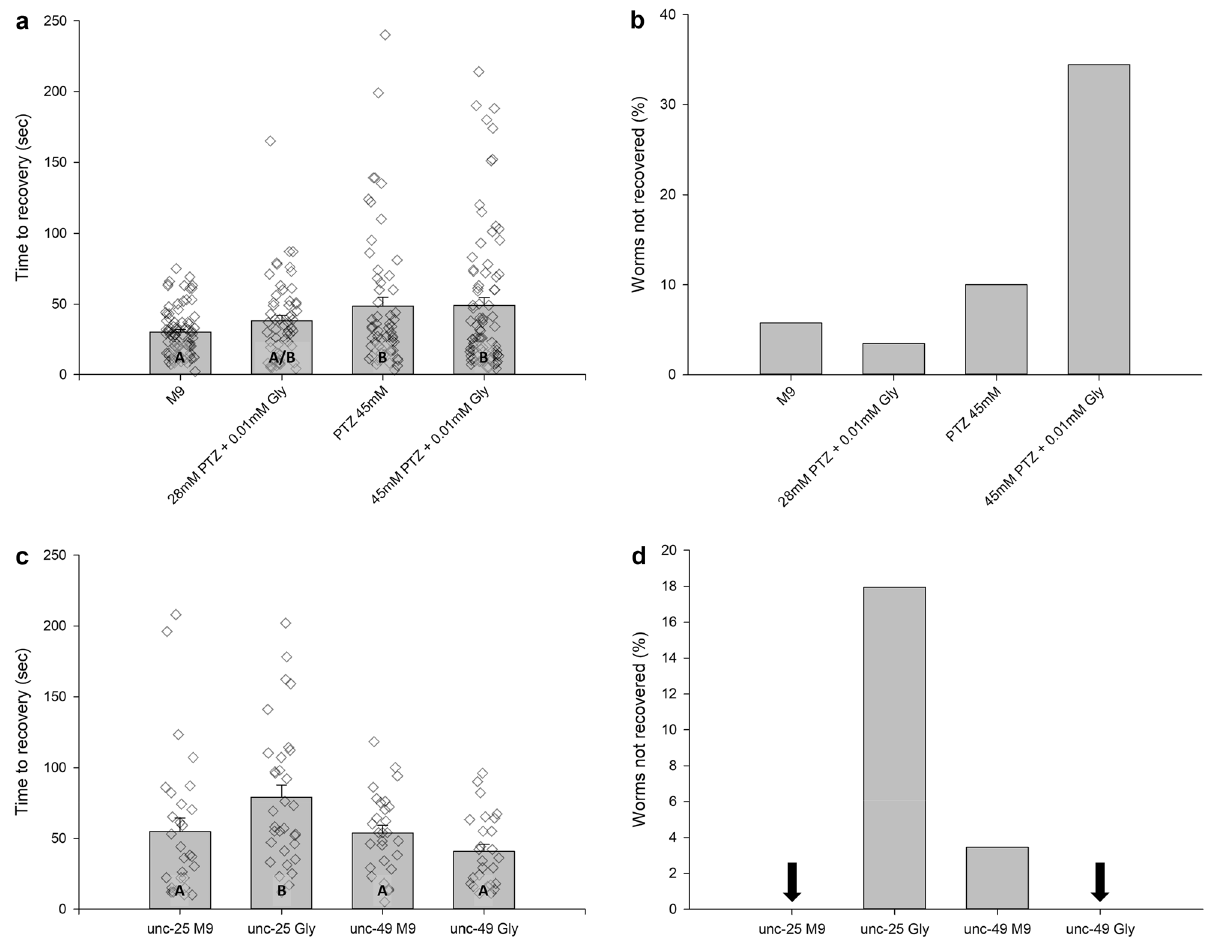
Figure 3. (a ) Average time to recovery for N2-wildtype nematodes exposed to M9 saline (n = 82), 28 mM PTZ + 0.01 mM glyphosate (n = 56), 45 mM PTZ (n = 81), and 45 mM PTZ + 0.01 mM glyphosate (n = 59). Data presented as mean seconds to recovery ± SEM. Raw data points were overlayed on the histograms. Statistical significance (p < .05) was designated using letters, where different letters show statistically significant differences, and the same letter indicates non-significance. P values between indicated conditions derived from a One-Way ANOVA followed by Student–Newman–Keuls Method for all pairwise multiple comparisons. ( b ) Percent of worms that did not recover from convulsion state when exposed to M9 saline (n = 87), 28 mM PTZ + 0.01 mM glyphosate (n = 58), 45 mM PTZ (n = 90), and 45 mM PTZ + 0.01 mM glyphosate (n = 90). Data presented as (number of worms not recovered in condition X/total number of worms tested in condition X) × 100. ( c ) Average time to recovery for unc -25 nematodes exposed to M9 saline (n = 30) and 0.1 mM glyphosate (n = 32), and unc -49 mutant strain nematodes exposed to M9 saline (n = 28) and 0.1 mM glyphosate (n = 26). Data presented as mean seconds to recovery ± SEM. Raw data points were overlayed on the histograms. Statistical significance (p < .05) was designated using letters, where different letters show statistically significant differences, and the same letter indicates non-significance. P values between indicated conditions derived from a One-Way ANOVA followed by Student–Newman–Keuls Method for all pairwise multiple comparisons. ( d ) Percent of worms that did not recover from convulsion state for unc -25 nematodes exposed to M9 saline (n = 30) and 0.1 mM glyphosate (n = 39), and unc -49 mutant strain nematodes exposed to M9 saline (n = 29) and 0.1 mM glyphosate (n = 26). Data presented as (number of worms not recovered in condition X/total number of worms tested in condition X) × 100. Arrow indicates that all worms recovered in the